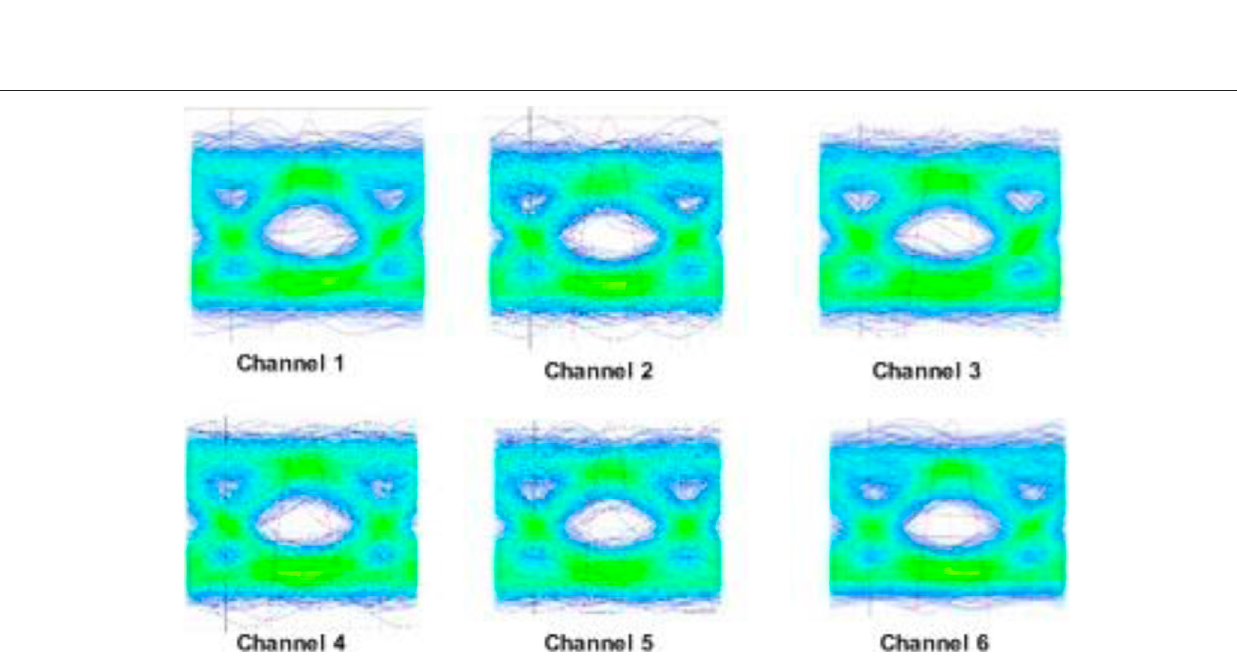
Frontiers in Physics |